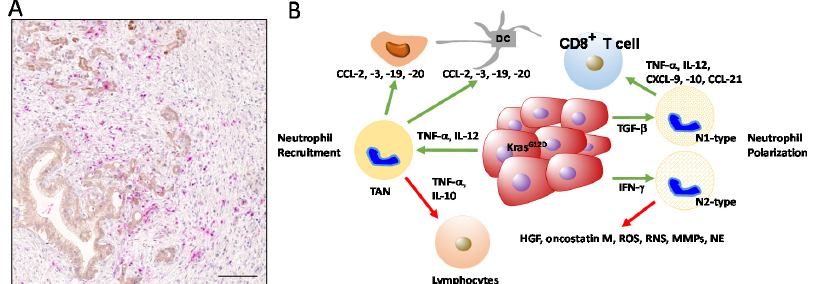
Figure 3. Tumor-associated neutrophils in pancreatic cancer. ( A ) Neutrophils in PDAC tumor stroma, stained with an antibody against Myeloperoxidase (MPO, pink). Ductal structures with tumor cells are stained in brown. Scale bar: 200 µm. ( B ) Signaling events leading to neutrophil recruitment (left side) and neutrophil polarization (right side). Activating signals are indicated by green, and suppressing signals by red arrows. Note that neutrophils can activate macrophages and dendritic cells, while they suppress lymphocytes. When polarized, the tumor-associated neutrophil (TAN) N1 type can activate CD8-positive T cells, whereas TAN N2 secretes a cocktail of tumor-promoting factors, such as hepatocyte growth factor (HGF), matrix metalloproteinase (MMPs), and neutrophils specific protease neutrophil elastase (NE). Furthermore, TAN N2 cells can cause an increased production of reactive oxygen and nitrogen species (ROS and RNS, respectively) and can cause hypoxic signaling.